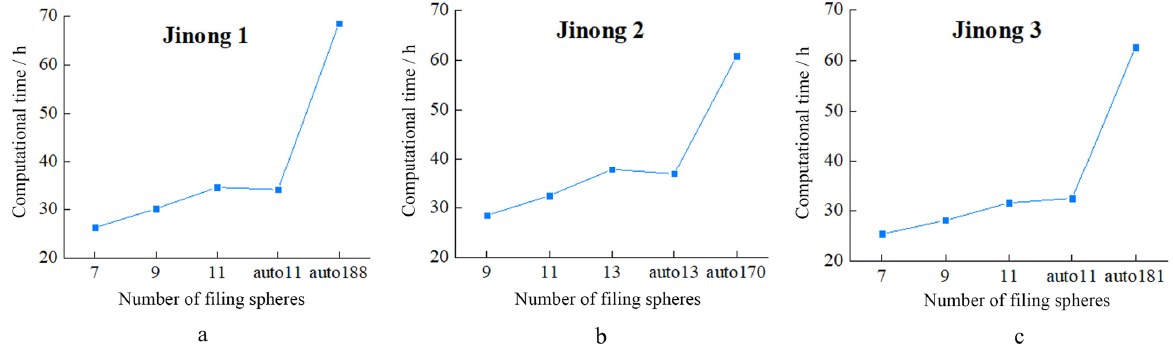
Figure 14. Computational times of the direct shear test simulation.